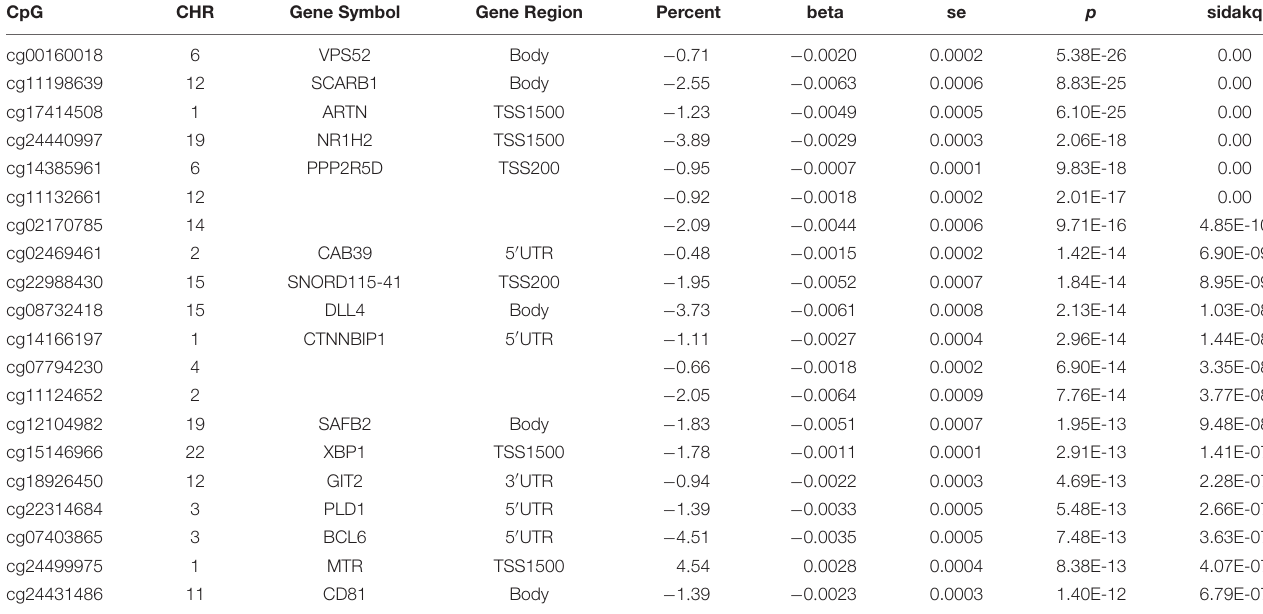
TABLE 2 | A 6-Month Aerobic Exercise Training–Induced Changes in DNA Methylation in African American MCI Subjects – Top 20 CpG Sites. CpG CHR Gene Symbol Gene Region